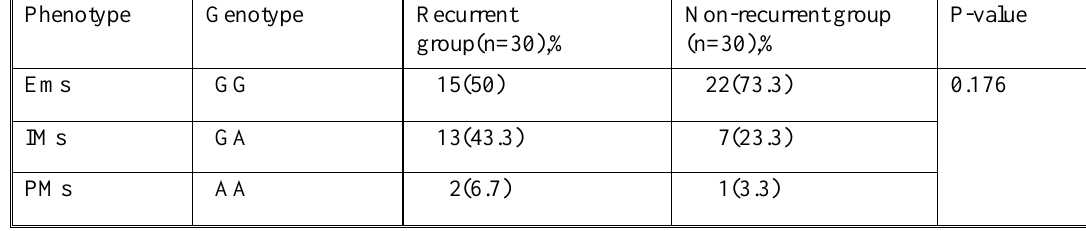
Table 3. Genotype and phenotype association with recurrent ischemic stroke.